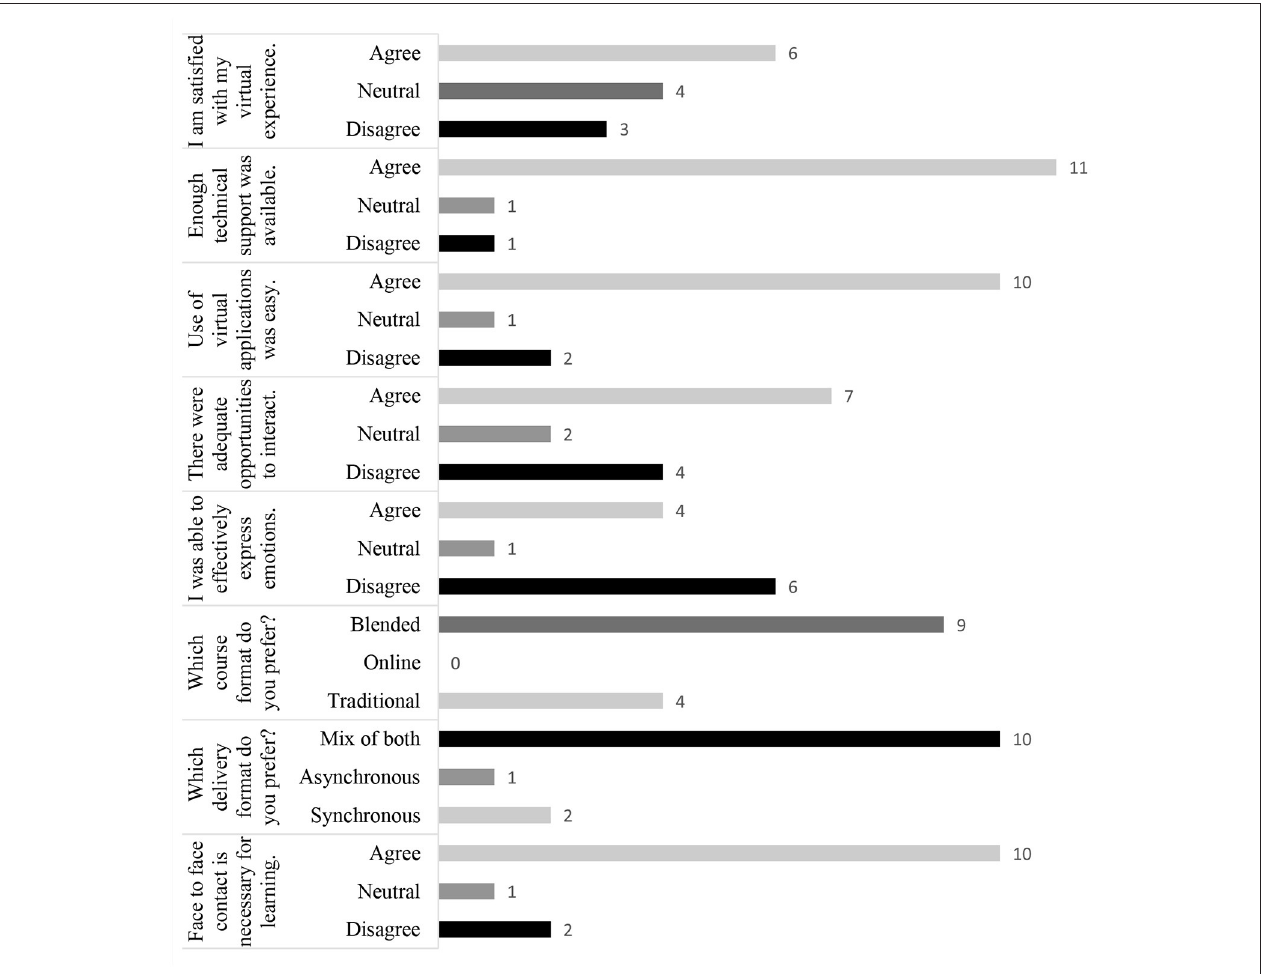
FIGURE 2 | Response from the faculty ( N = 13). Data are shown as the number of